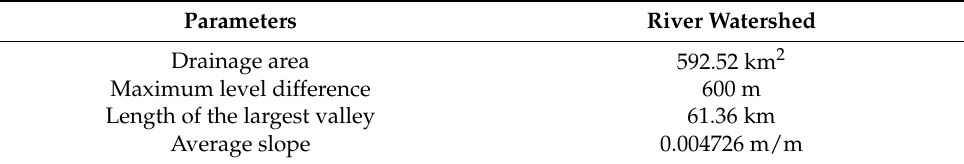
Figure 7. ( A ) Delimitation of the river watershed and ( B ) land use and land cover of the modeled area for industrial park site with the delimitation of the boundary conditions. Table 5. Physical information of the river watershed–industrial park